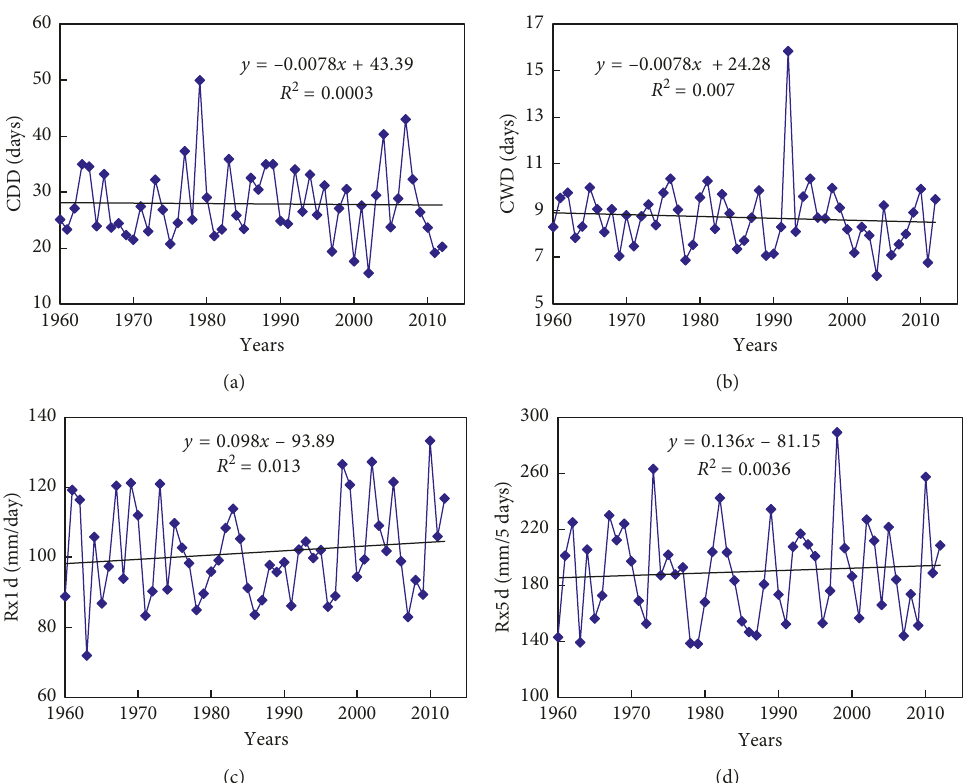
Figure 3: Variation of (a) CDD, (b) CWD, (c) Rx1d, and (d) Rx5d in Poyang Lake basin during 1960–2012.